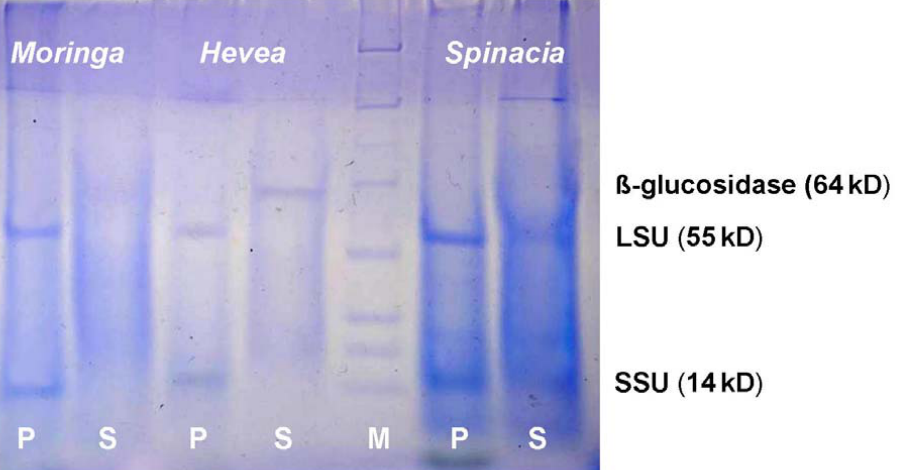
Fig. S1: SDS gel electrophoresis of various protein fractions. Protein was extracted from dried leaf material (commercial M. oleifera powder, africrops! , Ber- lin, and freeze-dried leaves from spinach and Hevea ) applying McIlvaine buffer (pH 5,6). The related supernatant (30,000 g) is denoted as S. Before